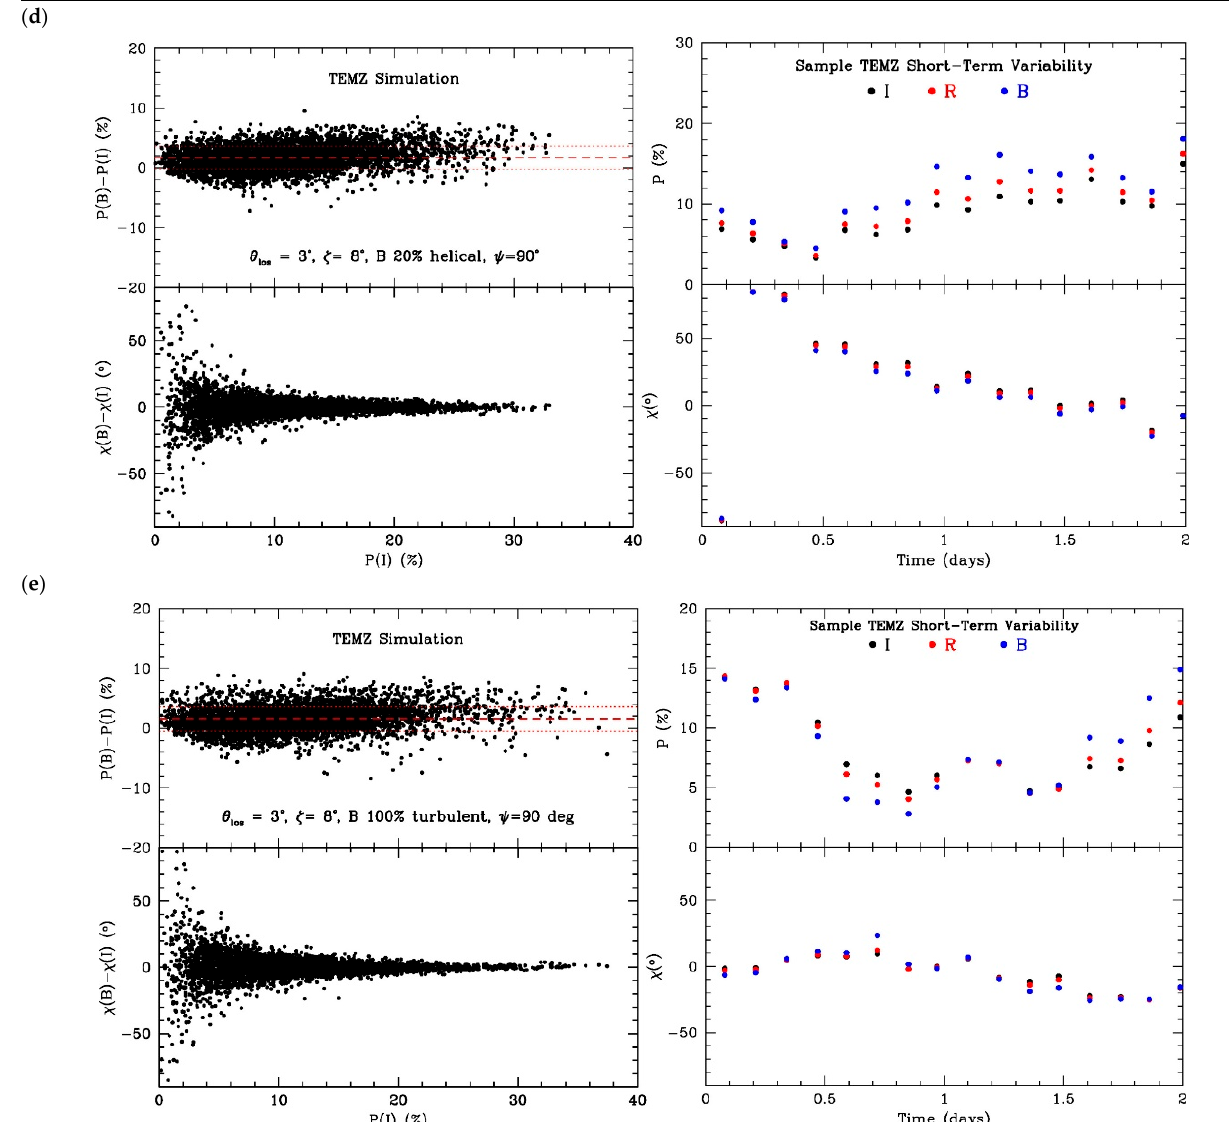
Figure 2. ( Left ) frequency and ( right ) short-term time dependence of the optical linear polarization of a turbulent jet with a standing conical shock representing the “core.” The ratio of ordered helical to total (helical + turbulent) magnetic field decreases from ( a ) 99%, ( b ) 60%, ( c ) 40%, ( d ) 20%, ( e ) 0%. The dashed red horizontal line in the upper left panels indicate the mean value of [ P (I) − P (B)], while the dotted lines demark ± 1 σ .